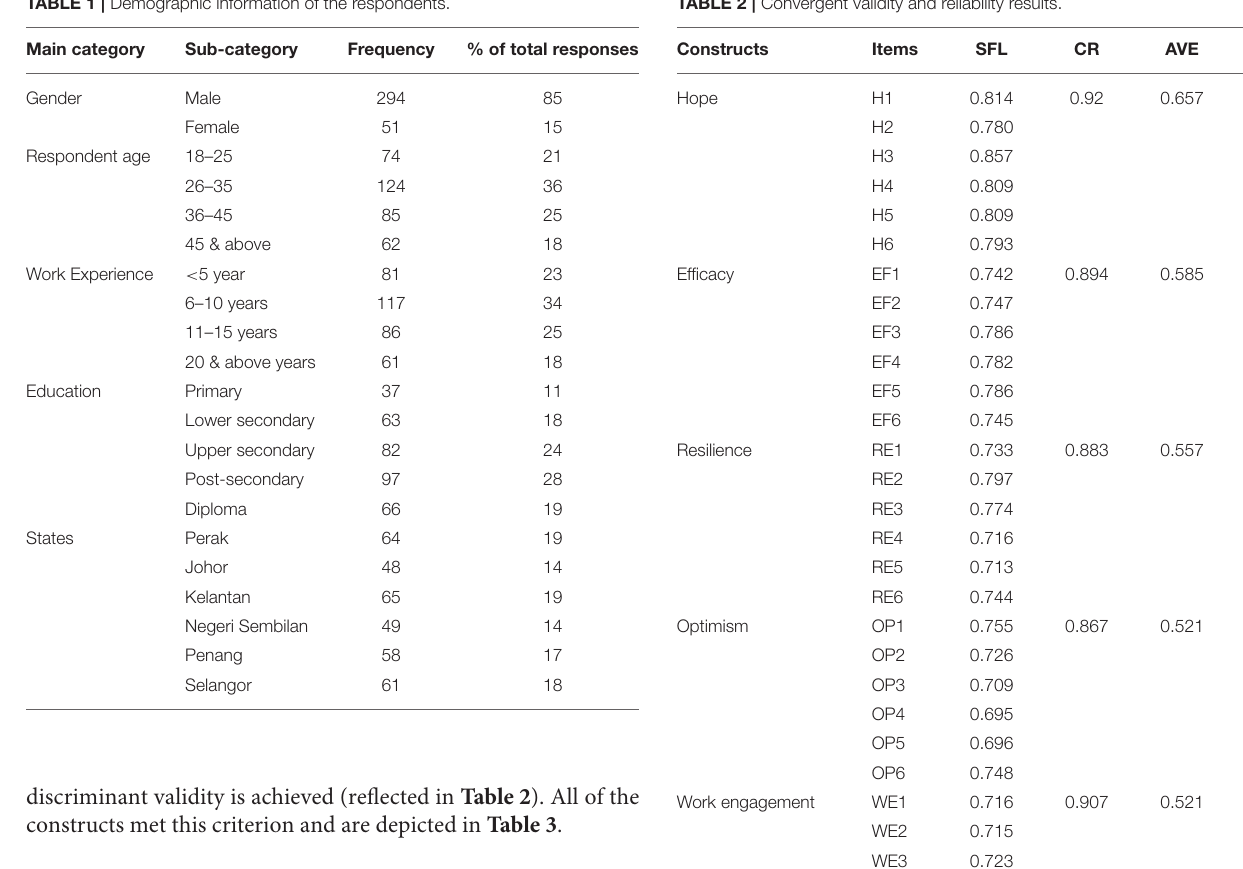
TABLE 1 | Demographic information of the respondents. TABLE 2 | Convergent validity and reliability results.